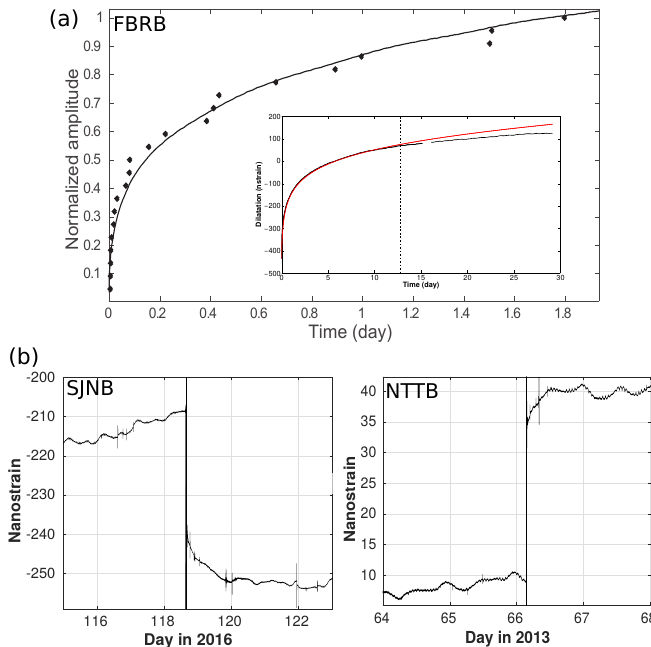
Figure 15. ( a ) Evolution of the cumulative number of aftershocks (black dots) with dilatation signal recorded by FBRB during the early stage of postseismic deformation (first 2 days). Signals are normalized by their maximal amplitude after 2 days. (Inset) Afterslip signal (black curve) and fit with a rate-dependent frictional model from (red curve) (Equation (4)) over a 1-month period. The dashed vertical line denotes the limit (first 13 days) for a satisfactory fit between observation and model that covers about 85–90% of the aseismic slip evolution. Figure adapted from Canitano et al. (2018) [29]. ( b ) Observations of short-lived (1–2 days) afterslip: (left) M L 5.7 earthquake at 26 km from SJNB and (right) M L 5.9 earthquake at 17 km from NTTB. Expansion is